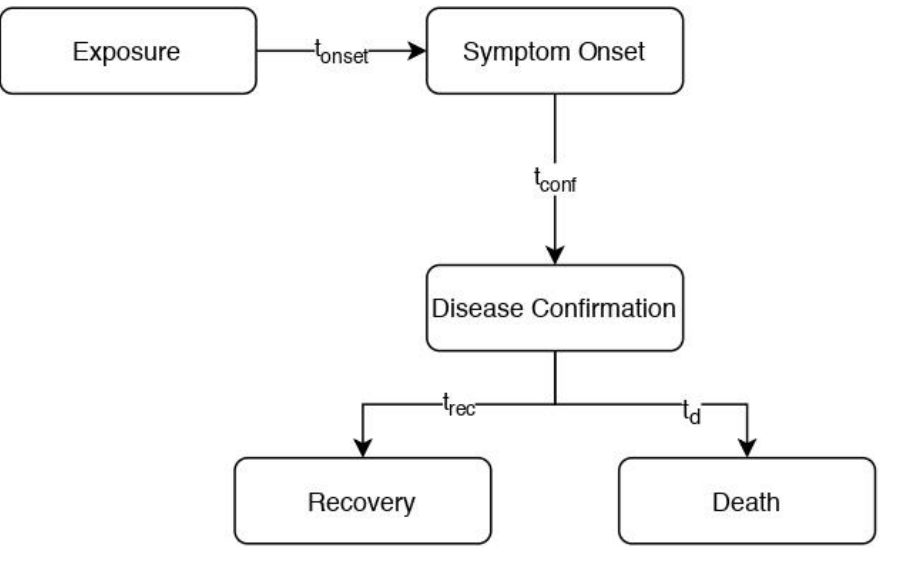
Figure 1. Model of disease progression.